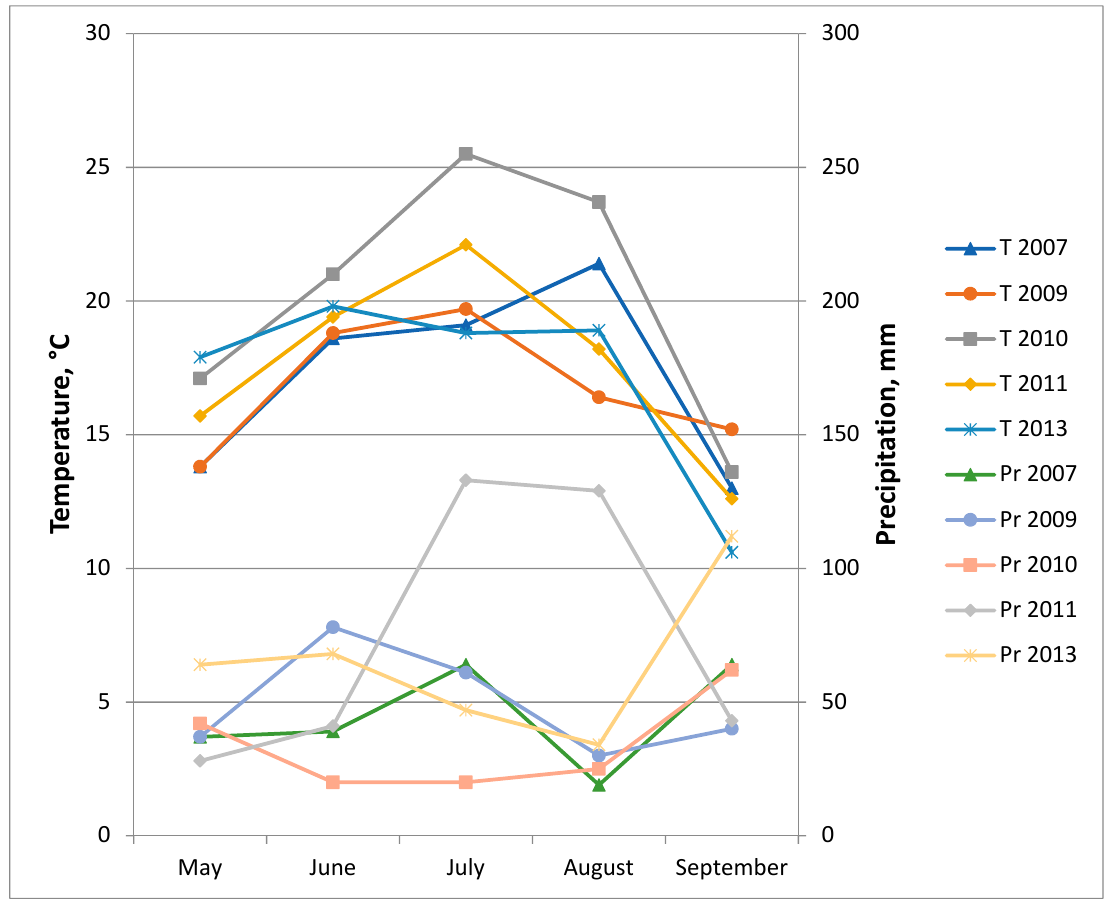
Figure 6. Weather conditions during growth seasons at field trial site (T—temperature, Pr—precipitation). Table 1. Segregation of uidA genes in progeny of transgenic